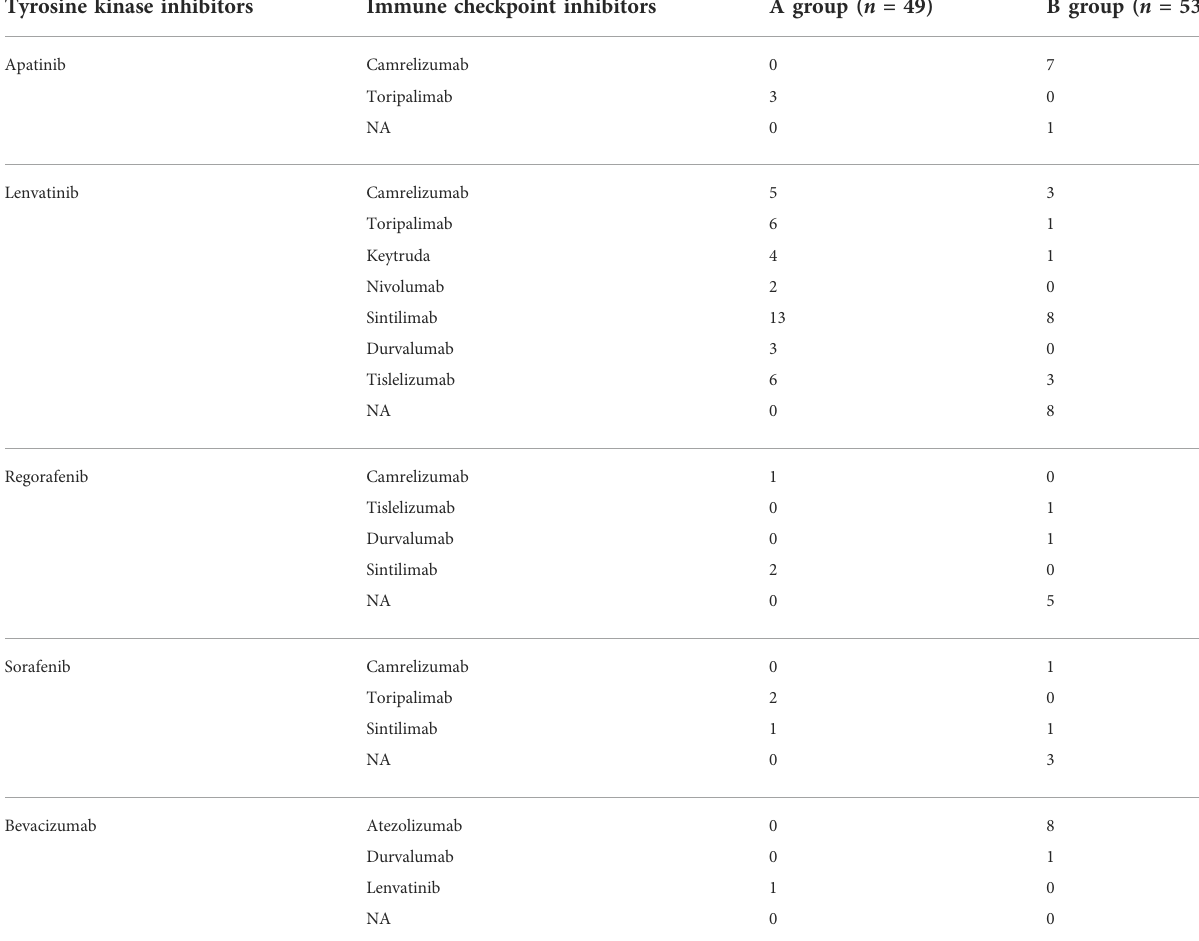
TABLE 2 Second-line treatment given to the patients. Tyrosine kinase